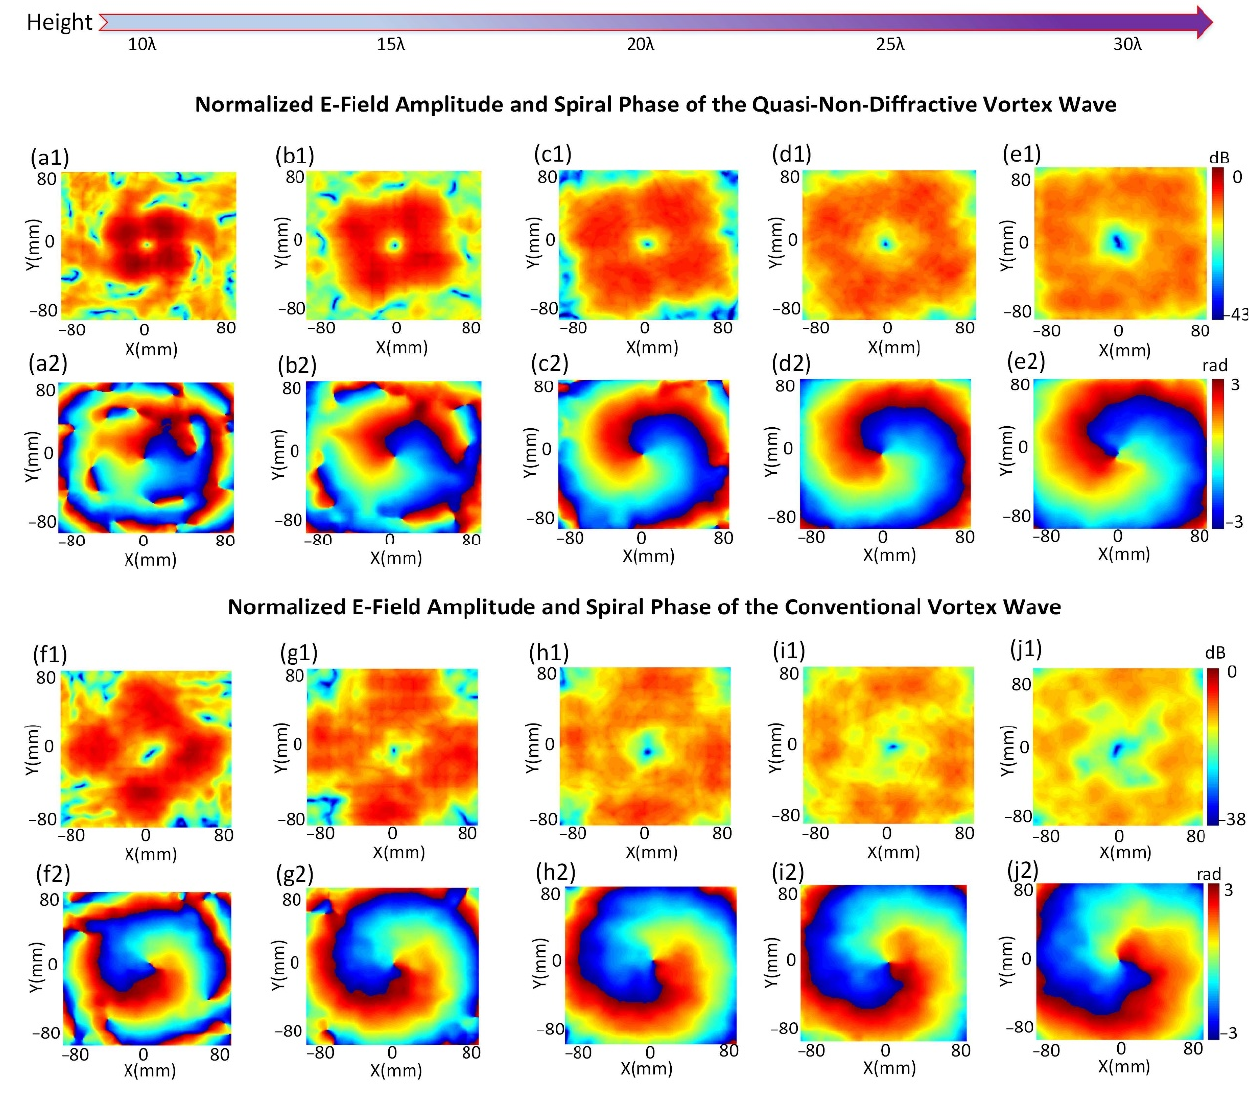
Figure 7. The ( a1 – e1 ) normalized E-field amplitude and ( a2 – e2 ) spiral phase distributions of the quasi-non-diffractive vortex wave generated from the proposed metasurface at a height of 10 λ , 15 λ , 20 λ , 25 λ and 30 λ above the metasurface, respectively, where λ is 15 mm. Similarly, the ( f1 – j1 ) normalized E-field amplitude and ( f2 – j2 ) spiral phase distributions of the conventional vortex wave are shown.